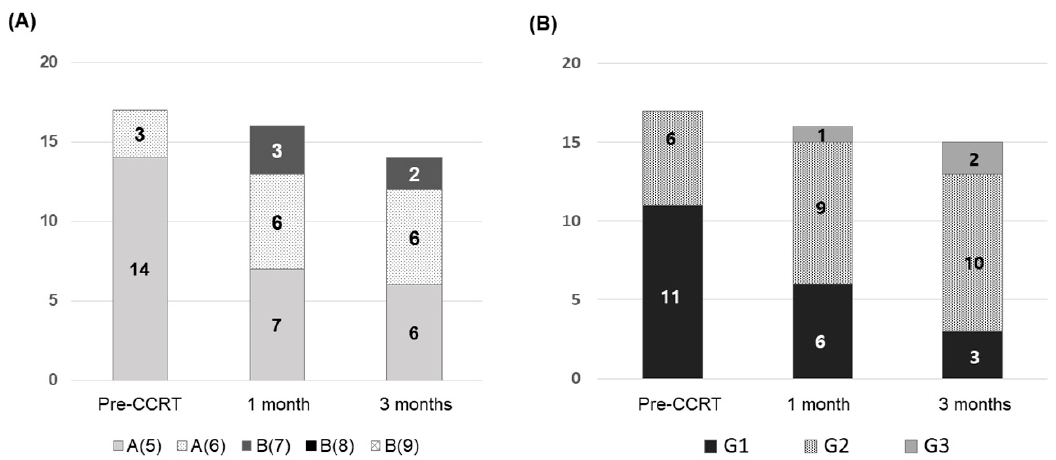
Figure 1. Changes of the liver function: ( A ) Child-Pugh score and ( B ) albumin-bilirubin grade before and after concurrent intra-arterial chemotherapy and radiotherapy (iA-CCRT).